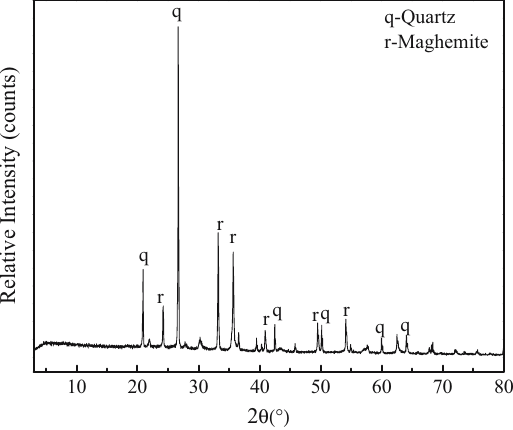
Figure 10: XRD spectra of magnetic